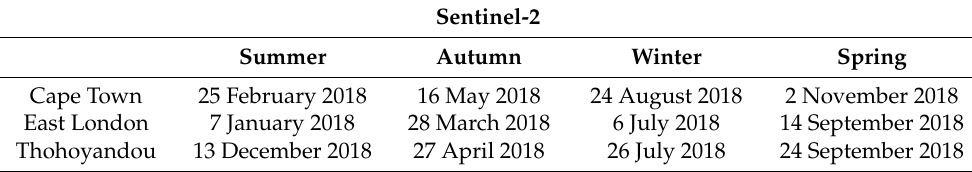
Table 1. Date and seasons for the Sentinel-2 imagery used throughout the classification